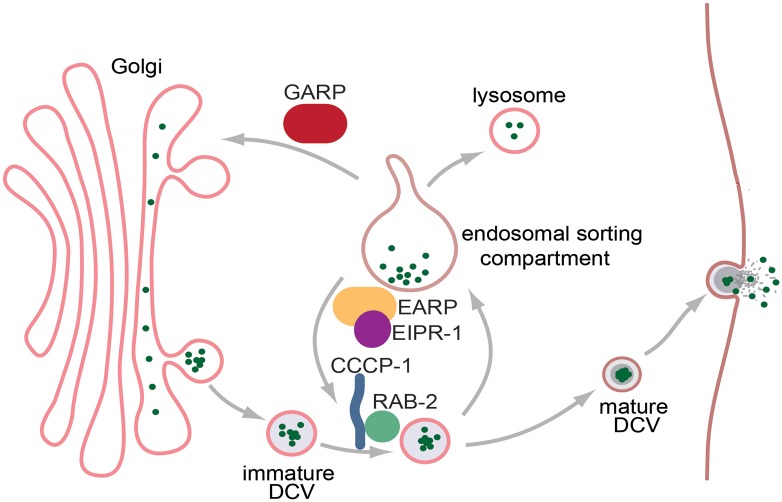
Model for dense-core vesicle cargo sorting.The EARP complex localizes to endosomal compartments and together with RAB-2 and its effectors (e.g CCCP-1) is involved in regulating cargo sorting to mature dense core vesicles. Dense-core vesicle cargo (green dots) is packaged into immature dense-core vesicles as they bud off from the trans-Golgi. During the process of dense-core vesicle maturation, EARP/EIPR-1 and RAB-2 regulate the trafficking of cargo or sorting factors through or from endosomal compartments. In mutants of RAB-2 or EARP/EIPR-1, increased trafficking of dense-core vesicle cargo to endosomes or the failure to retrieve cargo or sorting factors from endosomes may lead to the ultimate loss of cargos to lysosomes, and hence reduced cargo levels in mature DCVs. GARP acts in a distinct endosome to Golgi trafficking pathway.